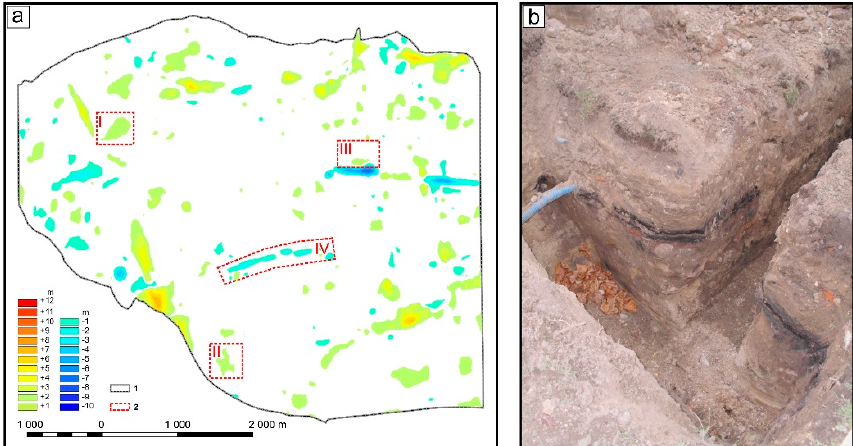
Figure 14. ( a ) Examples of relief changes due to new residential development and selected post- industrial buildings (1—boundaries covering the range of Jasi ń ski’s map; 2—areas of analysis); ( b ) Exposure showing land surfaces from before the construction of modern buildings; top surface of about 1 m (photo A. Szmidt 2021).